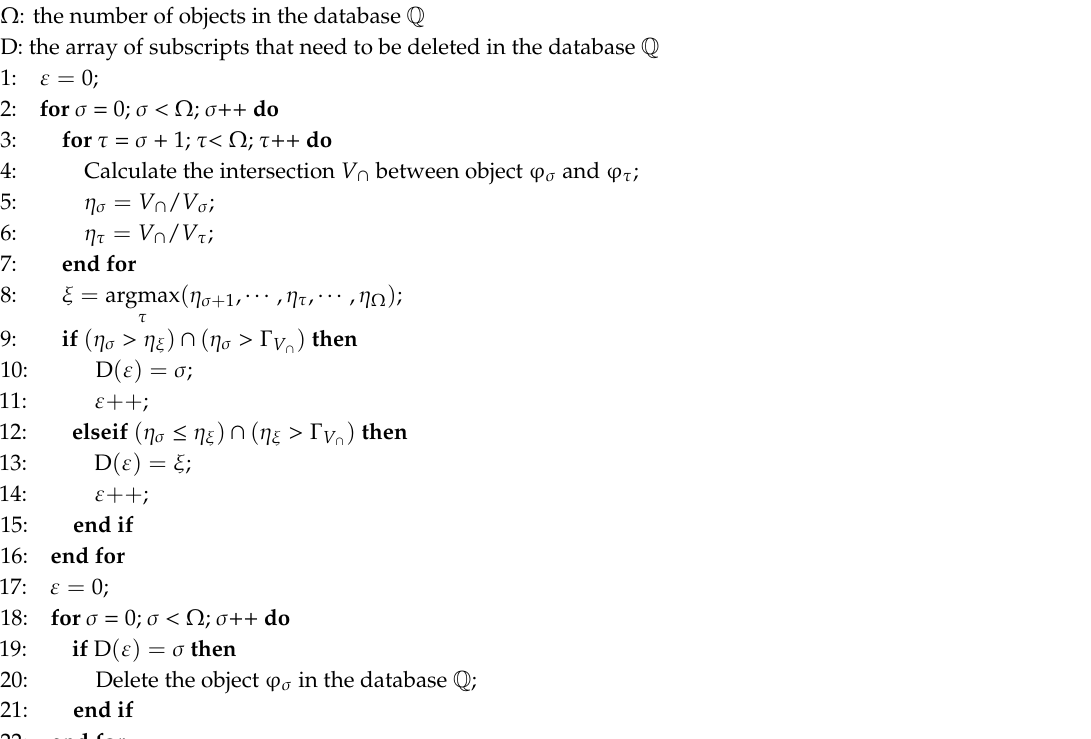
Algorithm 1: Intersection object filtering